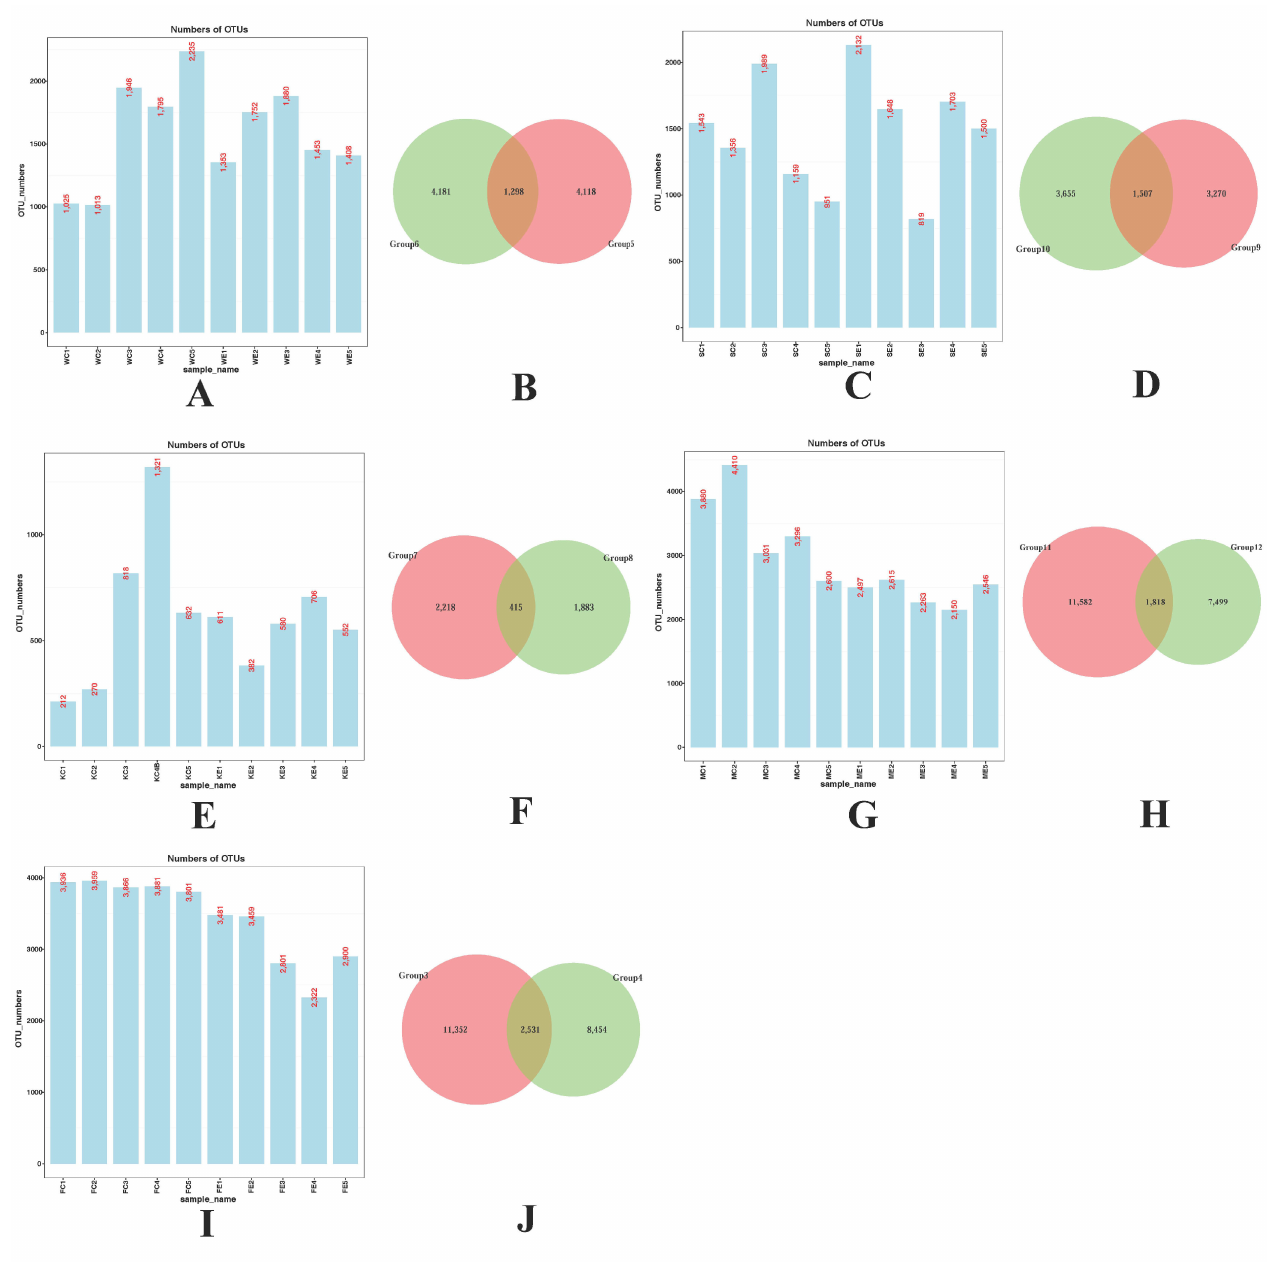
Figure 1. Diagrammatic representation of the effects of colistin on OTU changes in piglet guts ( A , C , E , G , I ). Venn diagrams show unique OTUs in the colistin and control groups, and shared by the groups (circle intersection) ( B , D , F , H , J ). ( A ) Stomach (Group 6, Group 5); ( B ) duodenum (Group 10, Group 9); ( C ) jejunum (Group 8, Group 7); ( D ) cecum (Group 12, Group 11); ( E ) feces (Group 4, Group 3); colistin treated group: Group 6, group 10, group 8, group 12, and group 4; the control group: Group 5, group 9, group 7, group 11, and group